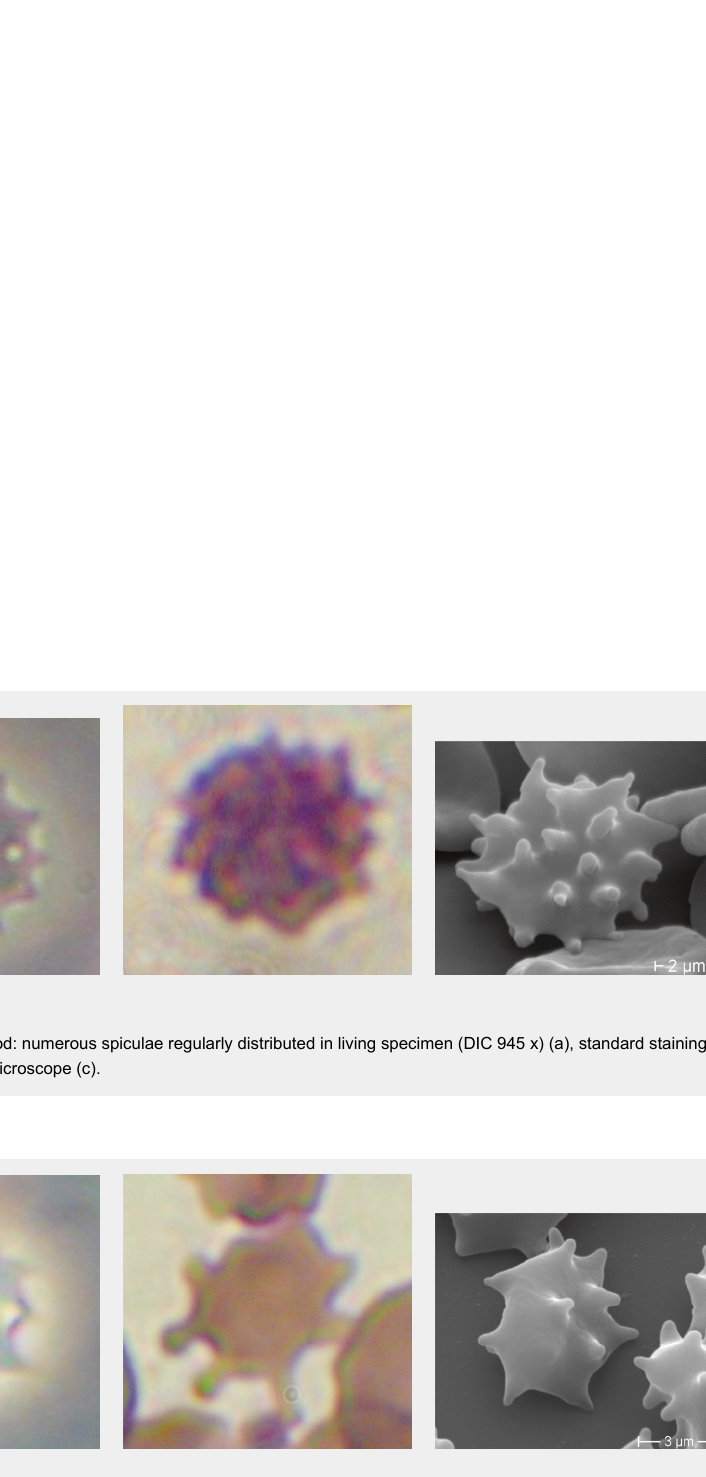
Figure 6 Acanthocyte in ChAc: fewer irregularly distributed spiculae, in living specimen (DIC 945 x) (a), standard staining (BF 1000 x oil) (b), and Scanning Electron Microscope